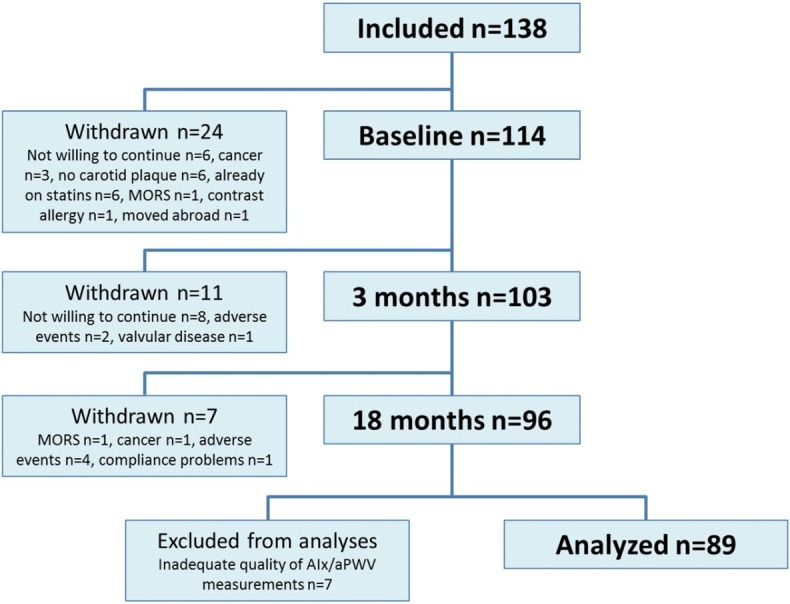
Flow chart of the ROsuvastatin in Rheumatoid Arthritis, Ankylosing Spondylitis and other inflammatory joint diseases (RORA-AS) study.Of the 138 patients who were initially included in the study, 24 patients withdrew. Ninety-six patients completed 18 months of treatment with rosuvastatin. Adequate quality of AIx/aPWV measurements was obtained in 89 patients who were included in the analyses.